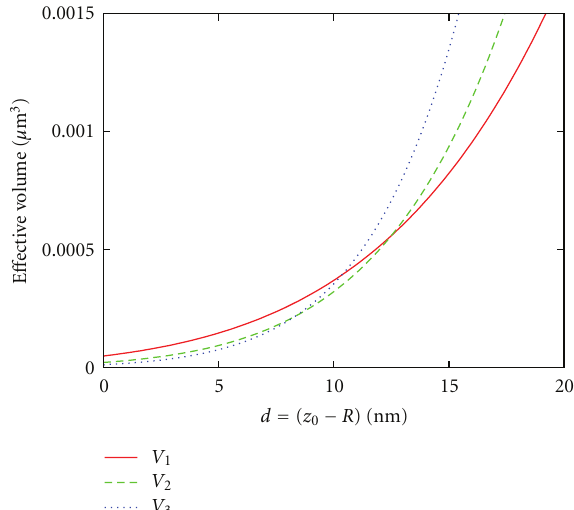
Figure 4: E ff ective volume of the dipole ( V 1 ), quadrupole ( V 2 ) and hexapole ( V 3 ) modes of a R = 25nm sphere as a function of the emitter-particle distance. The emitter is perpendicular to the particle